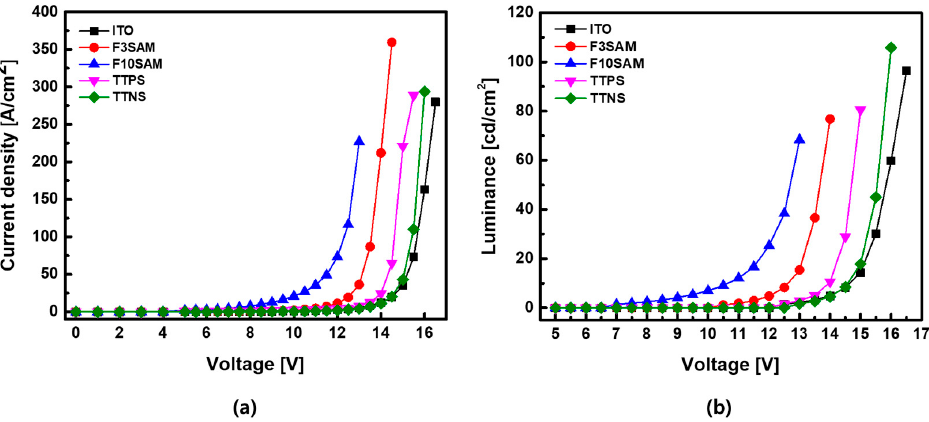
Figure 7. OLED characteristics: ( a ) J–V curve, ( b ) L–V curve.